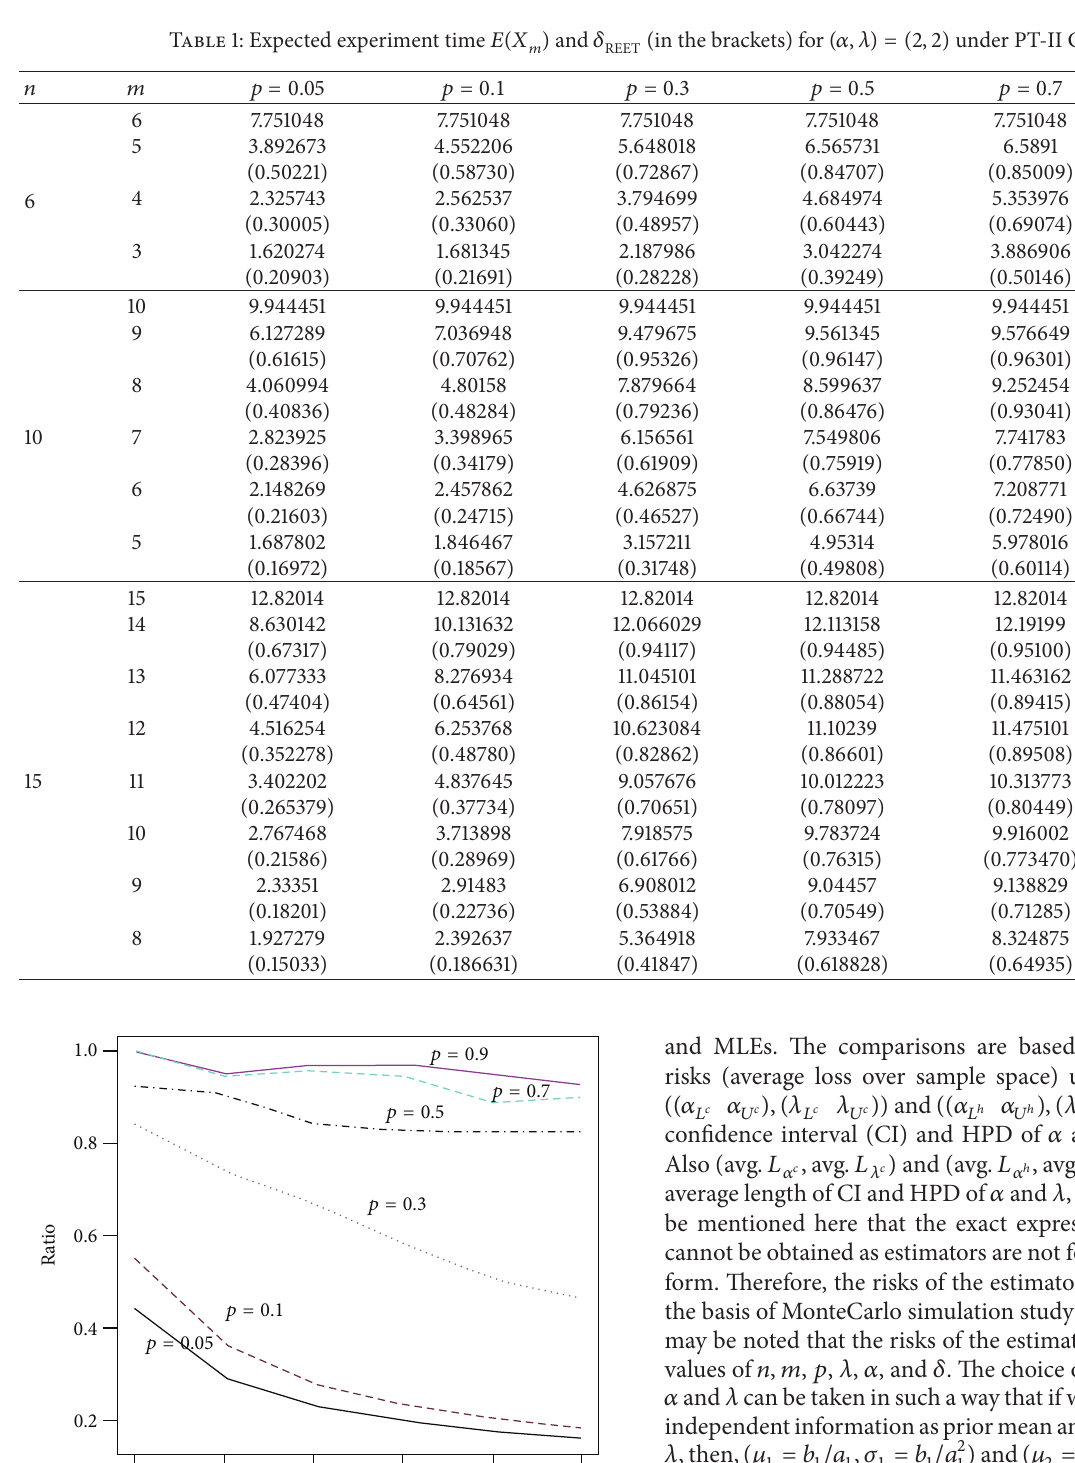
Table 1: Expected experiment time 𝐸(𝑋 𝑚 ) and 𝛿